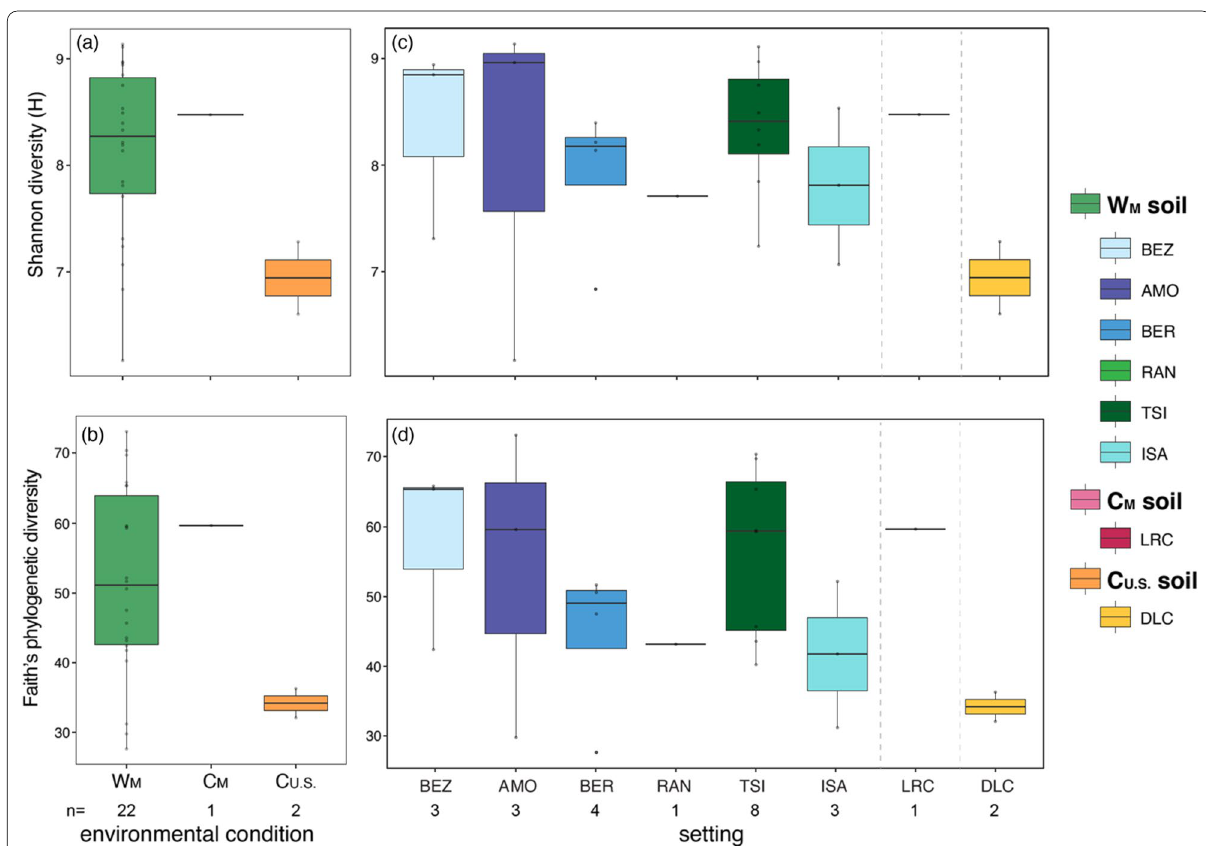
Fig. 5 Alpha diversity metrics of soil microbiota ( a , b ) collapsed by environmental condition, including the wilderness in Madagascar (W M ; green), captivity in Madagascar (C M ; pink), and captivity in the U.S. (C U.S. ; orange) and ( c , d ) averaged across individuals for each of the eight different settings (reprising the color codes of each condition, delineated by dashed vertical lines). Shown are both ( a , c ) Shannon diversity and ( b , d ) Faith’s phylogenetic diversity. Across the ( c , d ) settings within a condition (see Table 1 for names of abbreviated research settings), the data are plotted in descending order of mean Shannon diversity. Tukey-style box and whiskers show the median (center horizontal line) and the interquartile range (upper and lower bounds of the box), with outliers that are 1.5 times less than the 25th quartile or 1.5 times more than the 75th quartile. The number of samples (n) is reported below each environmental condition and